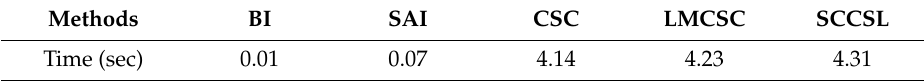
Table 3. Time comparison of different methods.